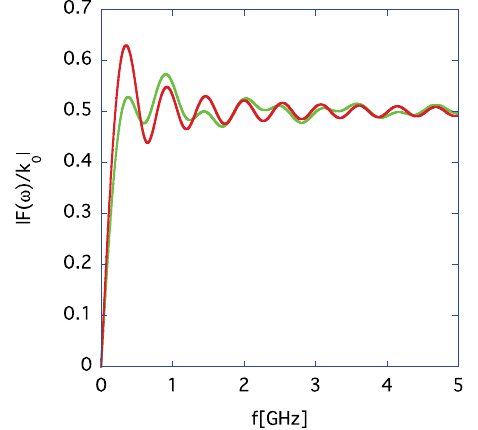
respectively.FIG. 16. The transfer function j F ð ω Þj for the concave pentagon electrode (green). That for the triangle electrode is shown by the red line for comparison.